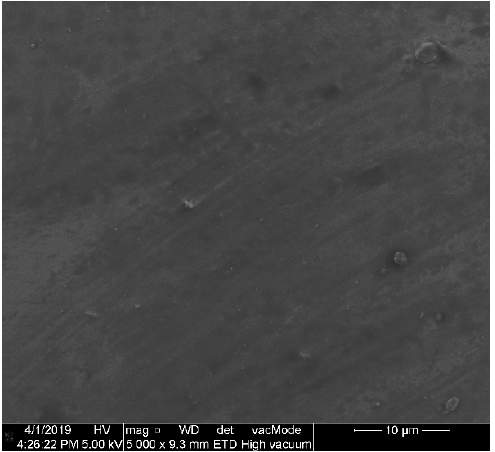
Figure 2. Scanning Electron Microscopy (SEM) image of the ALD ZnO coating deposited on the surface of the microsphere with 5000× magnification.